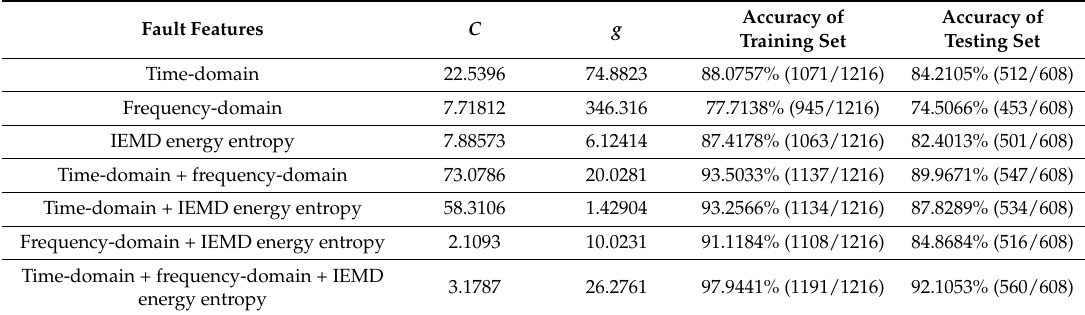
Table 6. PSO-SVM classification results of different fault